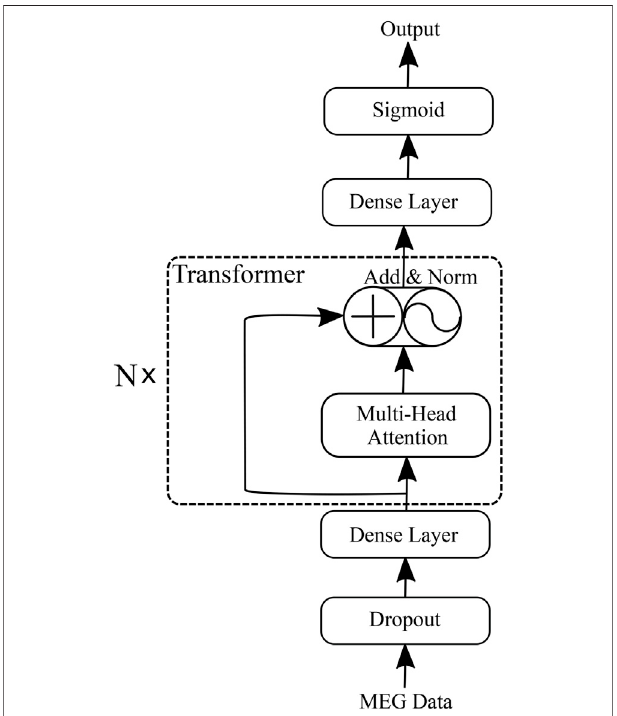
FIGURE 2 | Transformer-based HFO (TransHFO) classi fi cation